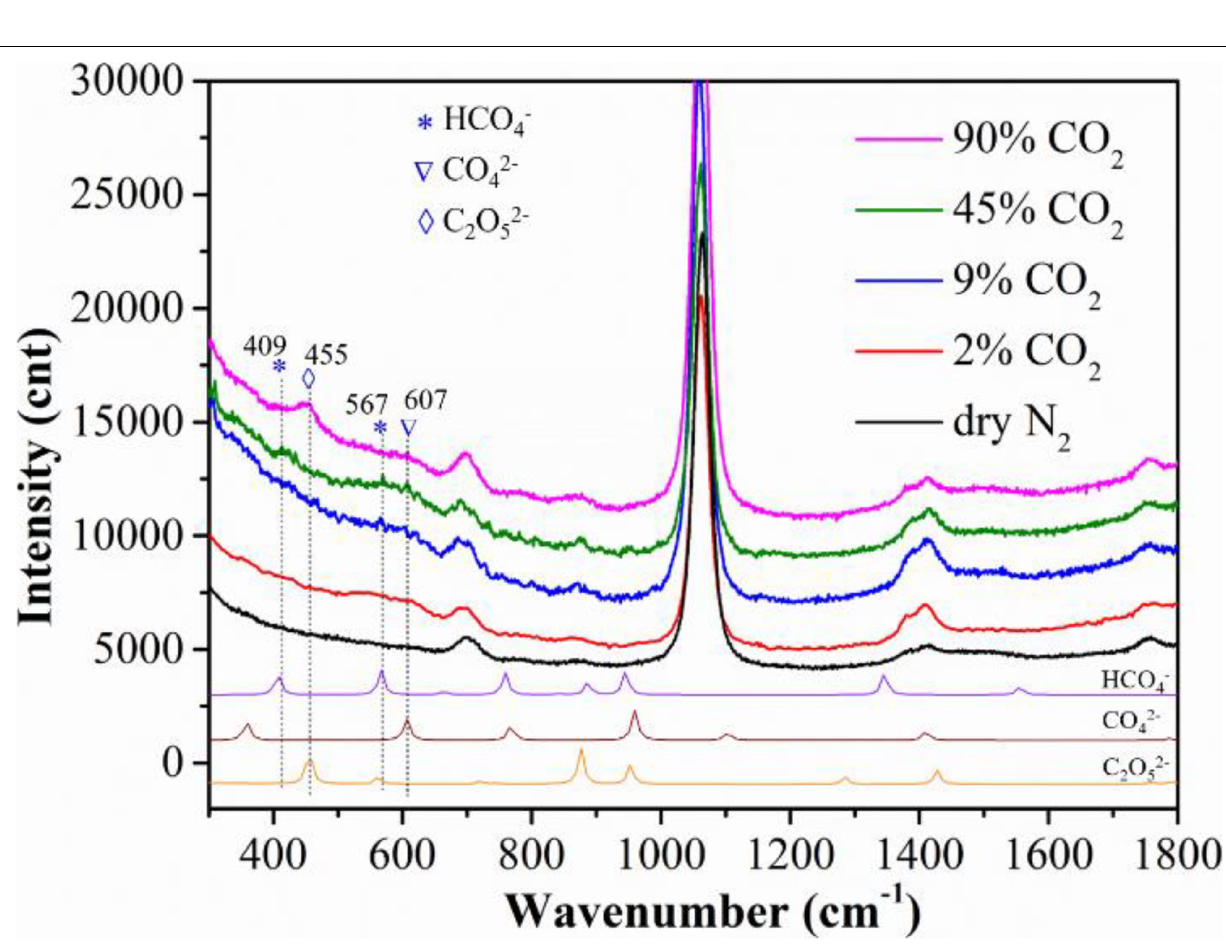
Frontiers in Energy Research |